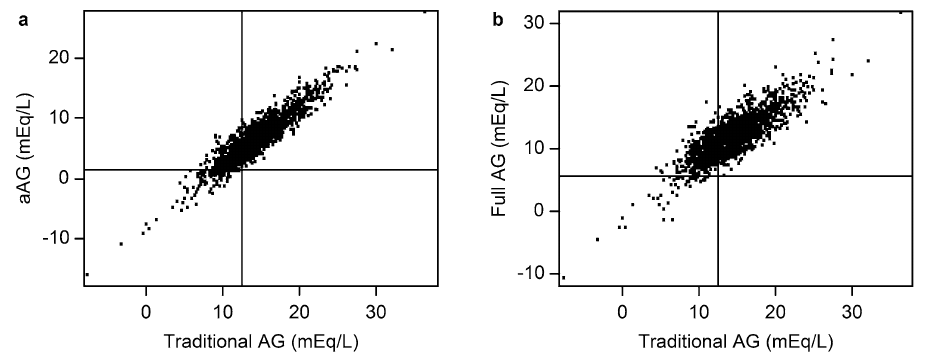
Figure 2. Diversity of the albumin-adjusted and full AG values against the traditional AG value in ESKD. ( a ) Traditional AG value against the aAG value. The added horizontal line indicates the upper limit of aAG (1.47 mEq/L). The added vertical line indicates the upper limit of traditional AG (12.42 mEq/L). The left upper graph area indicates a false-negative diagnosis by the traditional AG equation (aAG: albumin-adjusted AG). ( b ) Traditional AG value against the full AG value. The added horizontal line indicates the upper limit of full AG (5.69 mEq/L). The added vertical line indicates the upper limit of traditional AG (12.42 mEq/L). The left upper graph area indicates a false-negative diagnosis by the traditional AG equation.